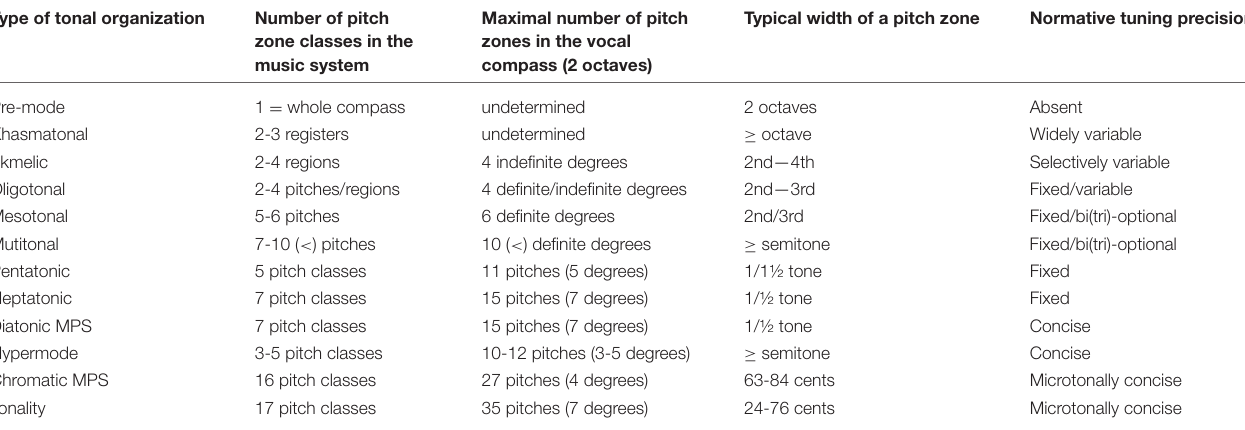
Table 2 | Pitch zone discrimination throughout the evolution of tonal organization in low voice vocal